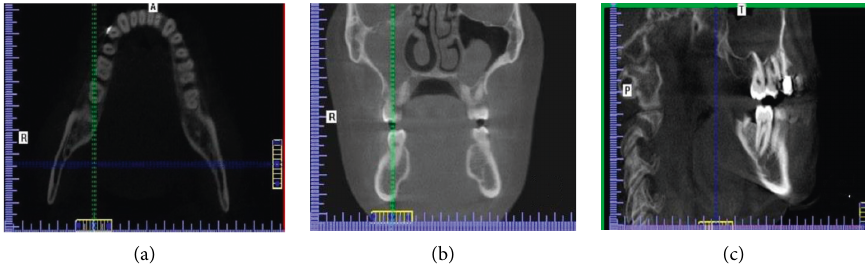
Figure 1: Cone-beam computed tomography images. (a) Axial view. (b) Coronal view. (c) Sagittal view.